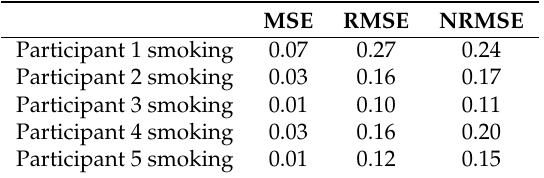
Table 6. The overall error rate of the proposed model over the weekends.